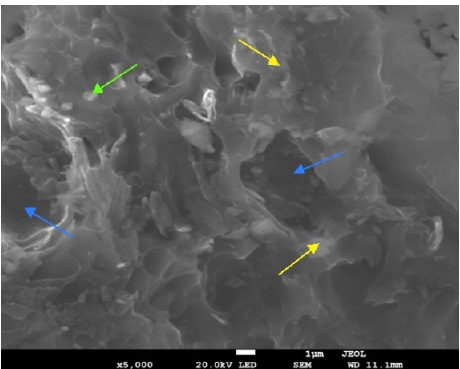
Figure 2. Scanning electron microscope (SEM) surface topography of carbon dust.